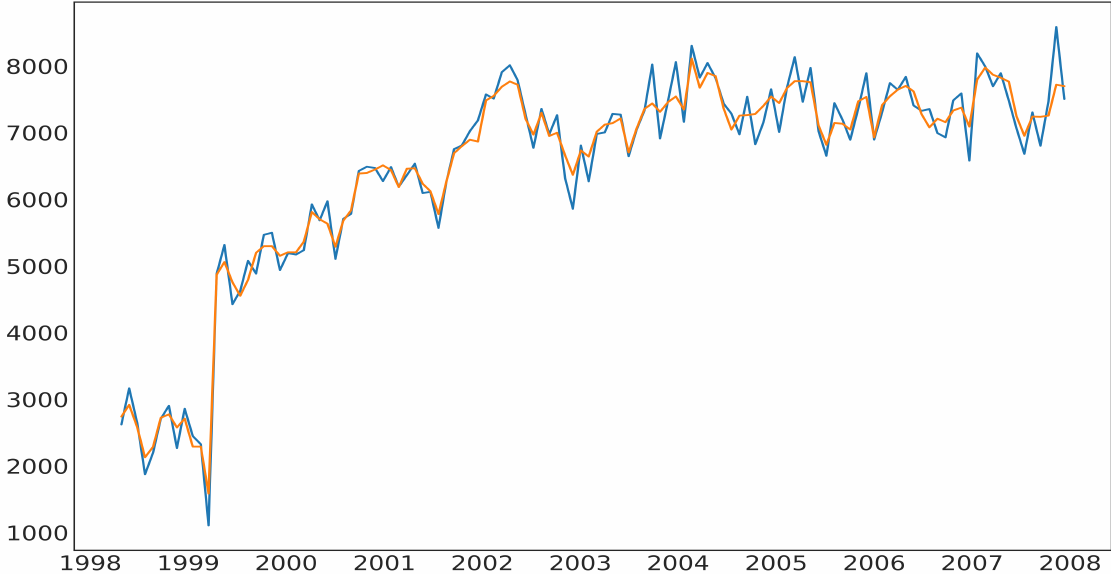
Figure 6. Forecasted values for crime by XGB